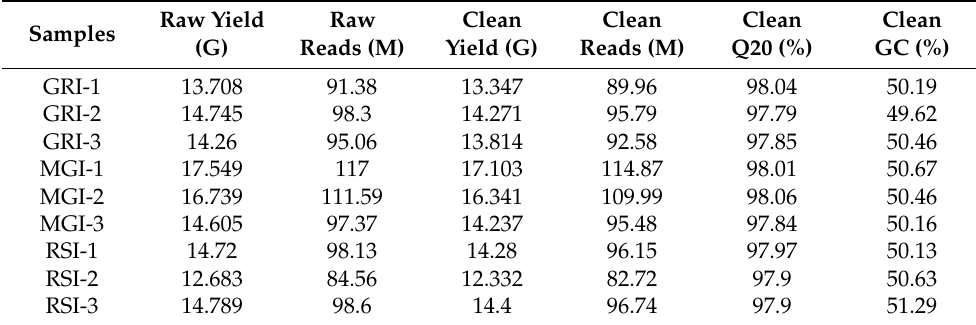
Table 1. Summary of RNA_seq in Qingyu pigs.